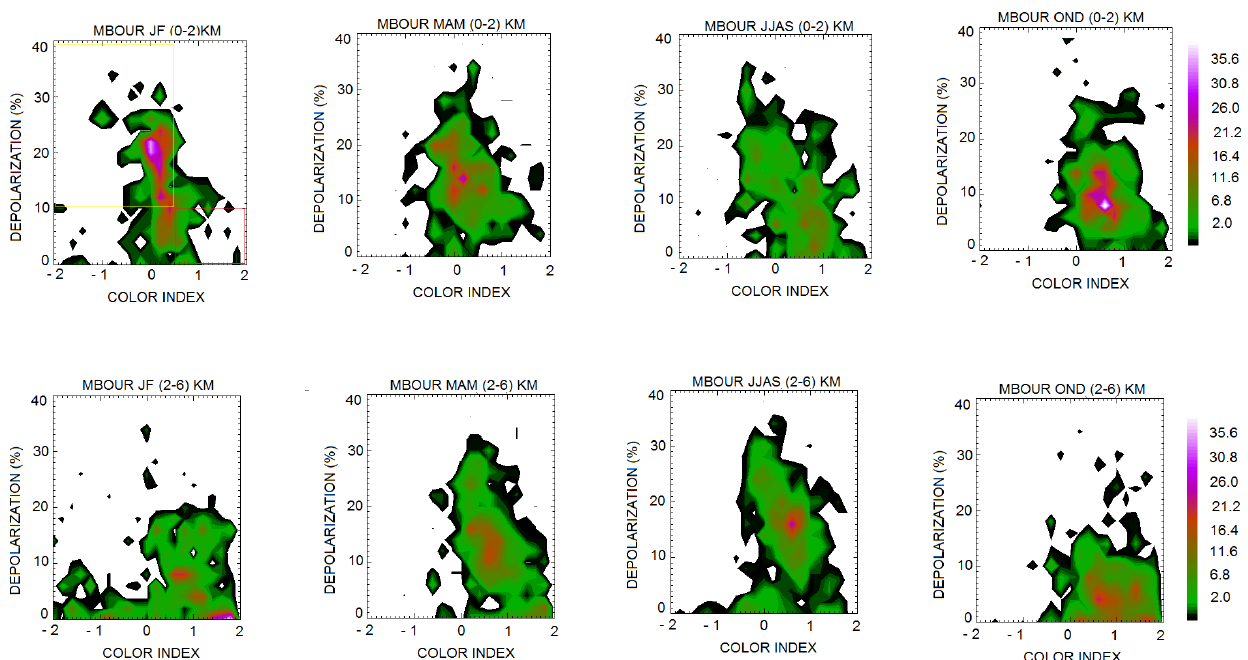
Fig.8. Joint PDF for Color Index and Depolarization retrieved from CALIOP observations for different seasons over M’Bour site. In column 1 we depicted JF, in column 2 MAM, in column 3 JJAS, and in column 4 OND. Upper row show results for a boundary layer (0-2 km) and lower for free troposphere (2-6 km). In the upper left subplot yellow and red rectangles identify, respectively, desert dust and biomass burning aerosols classified using criteria specified in Table 4. Colored rectangles are shown only in one subplot for brevity.